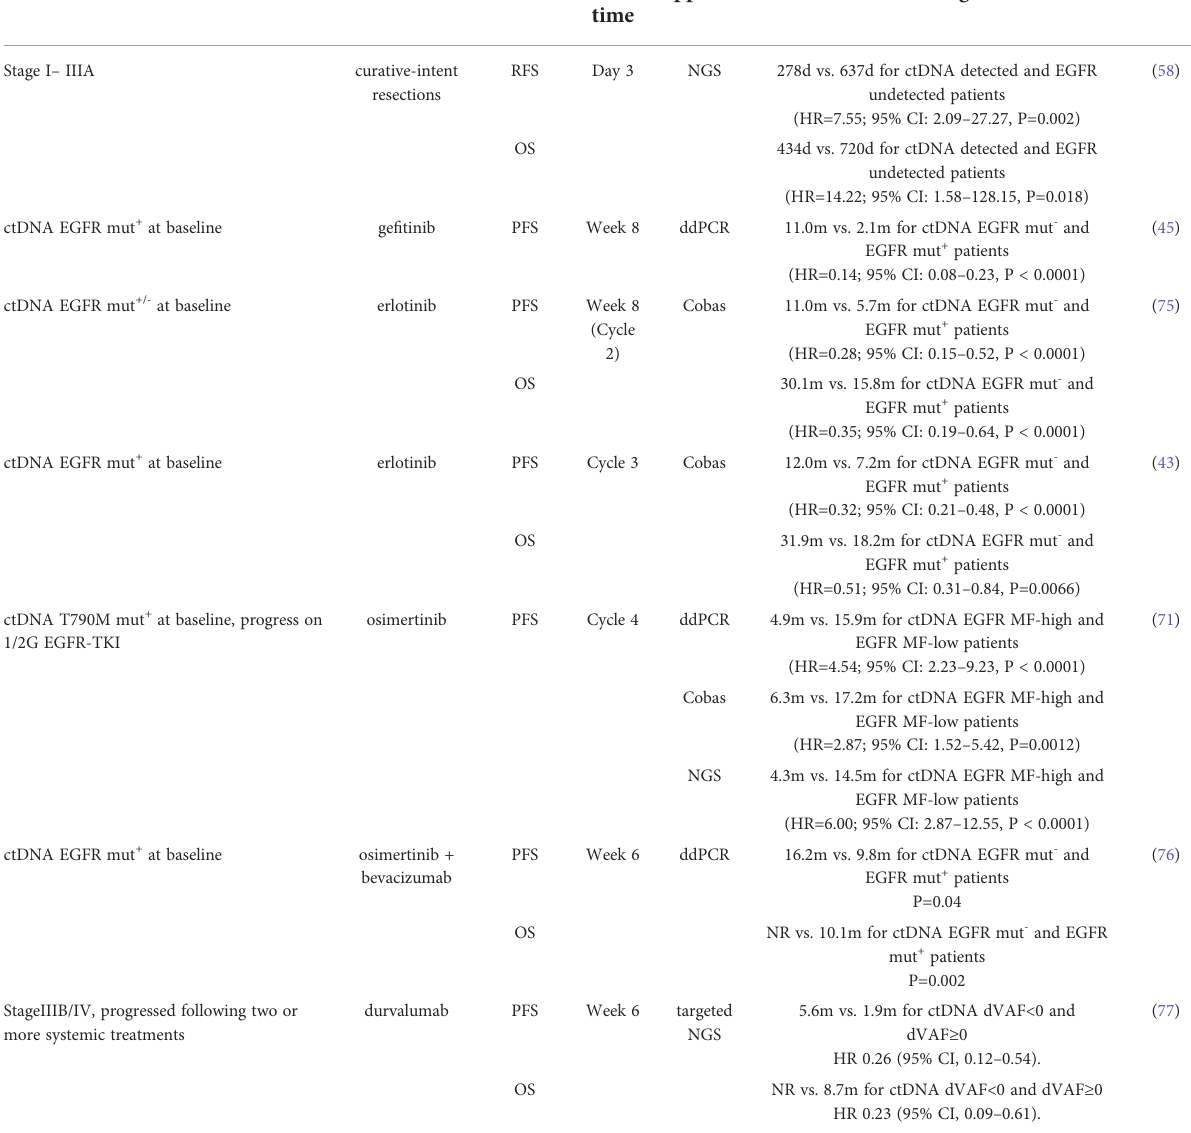
TABLE 2 ctDNA as a treatment response